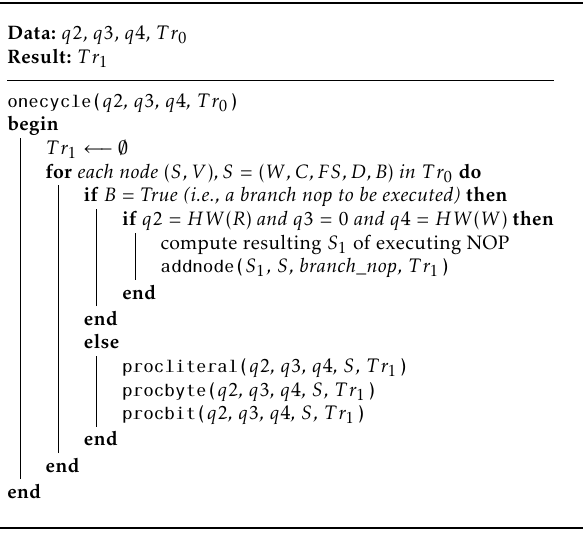
Algorithm 1: onecycle : Compute all the possi- ble instructions and resulting states that satisfy a given side-channel constraint ( q 2 , q 3 , q 4) for one instruction cycle.